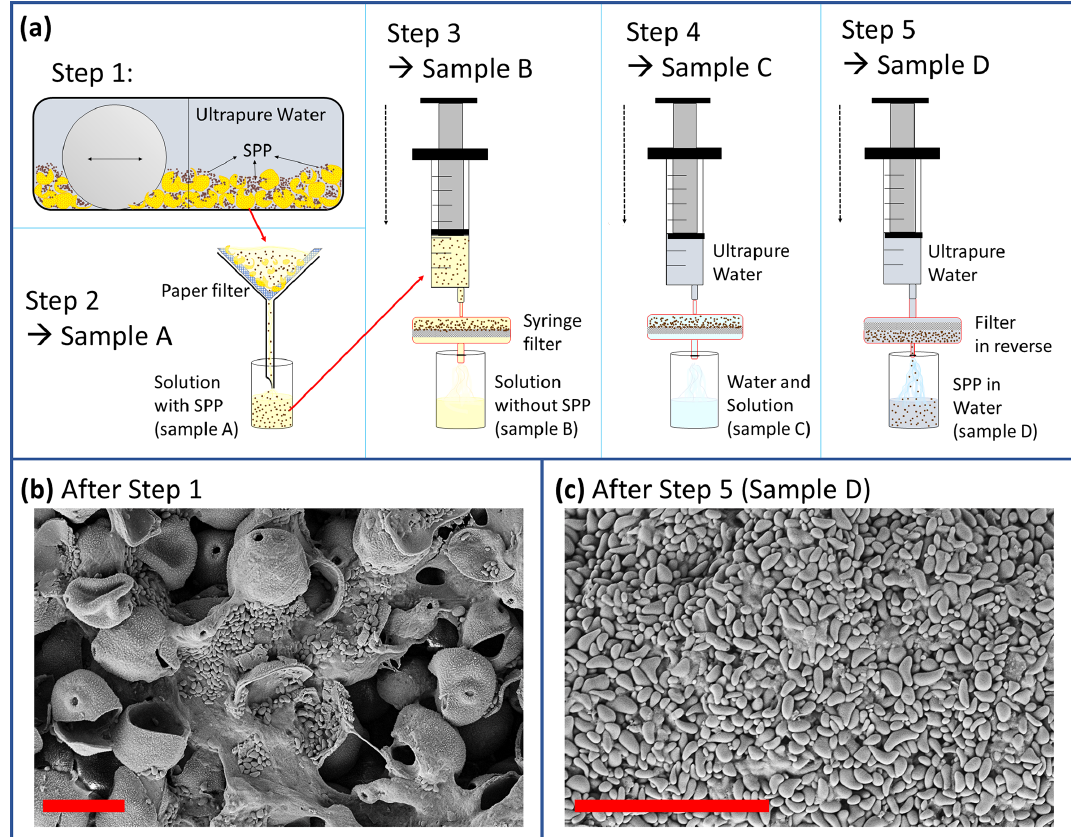
Figure 2. (a) Extraction process of SPPs. Step 1: entire pollen grains mixed with ultrapure water are crushed in a mixer mill (MM400, Retsch GmbH, Haan, Germany). Step 2: the sample is filtered so that entire pollen grains and large outer shells are excluded. Step 3: filtration with a 0.2µm pore sized filter. Step 4: the filter including the SPPs is rinsed with ultrapure water to wash off soluble material. Step 5: the filter is reversed and the SPPs are extracted with ultrapure water. (b) Crushed pollen grains, cytoplasmic material, and SPPs (starch granules) after step 1. (c) Extracted SPPs after step 5. Red scale bar is